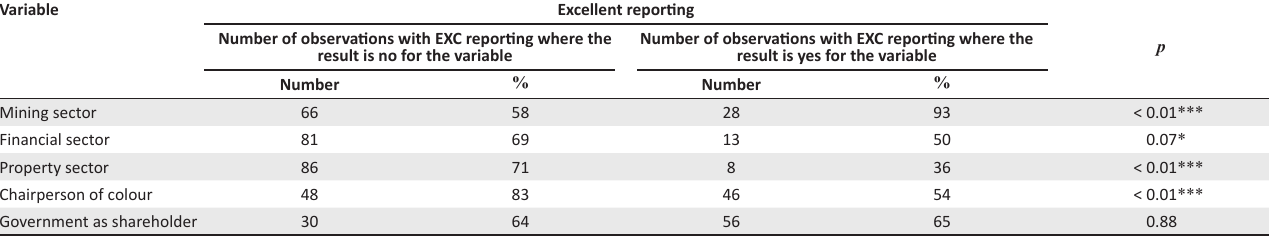
TABLE 3: Results of the categorised histogram. Variable Excellent reporting